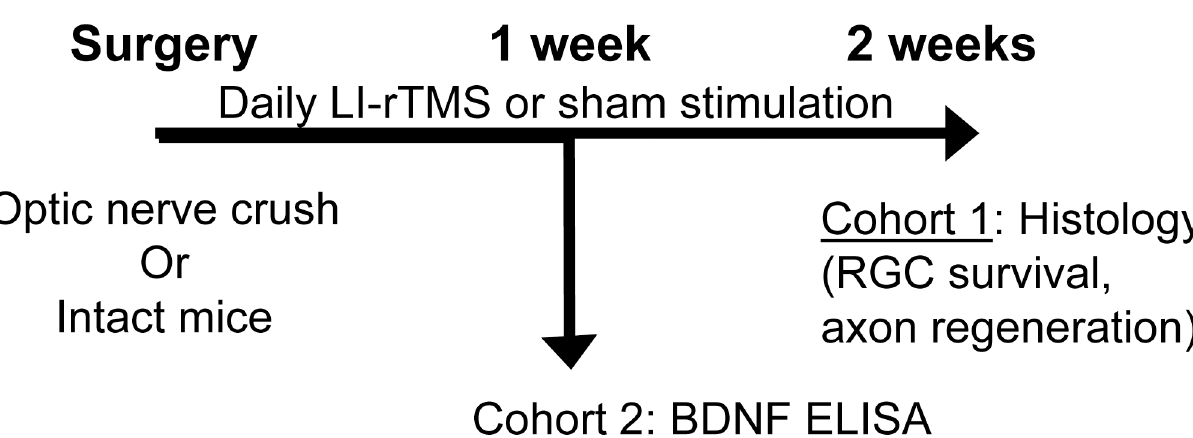
Fig 1. Diagrammatic representation of the study design. Mice received an optic nerve crush and were separated into two cohorts for (i) daily LI-rTMS or sham stimulation and assessed for RGC survival and axonal regeneration (2 weeks survival) (ii) quantification of BDNF levels by ELISA (1 week survival). With the second cohort, additional control groups of intact mice with no optic nerve crush were processed in parallel for BDNF analysis with the same LI- rTMS or sham stimulation parameters.